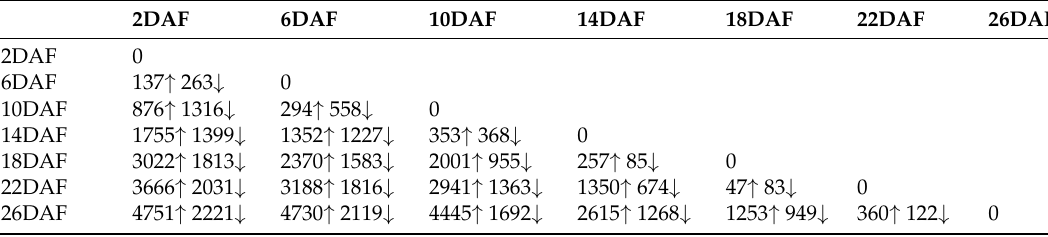
Table 4. Differentially Expressed Genes (DEGs) between two different developmental